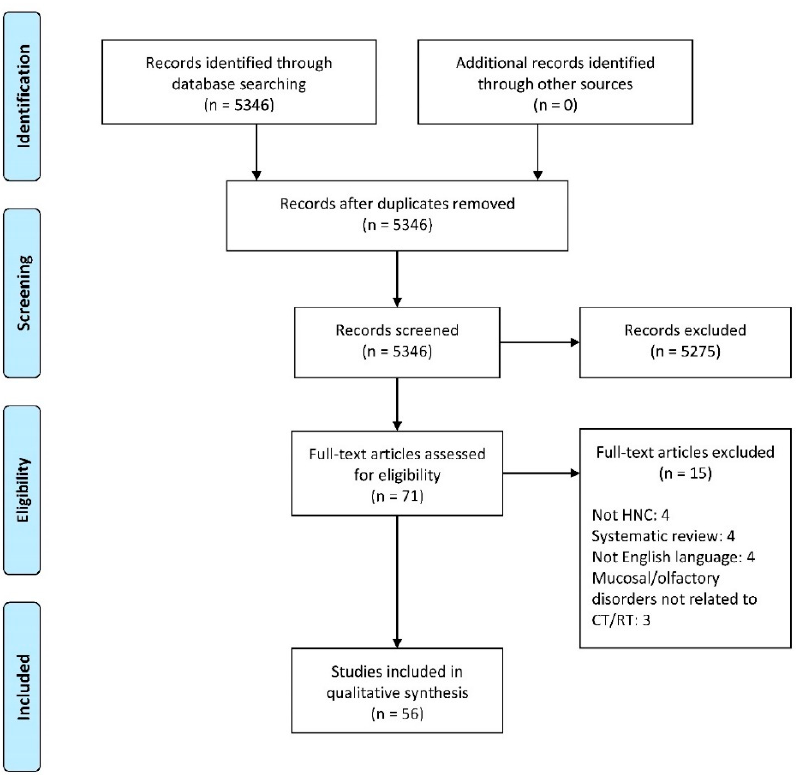
Figure 1. Flow diagram of the included studies.